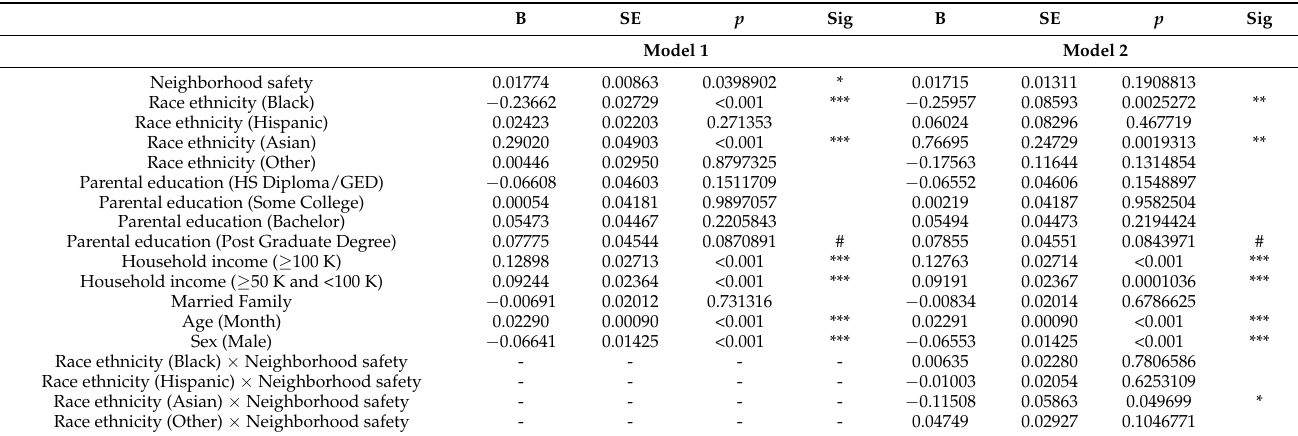
Table 4. Summary of mixed-effects regressions on the association between parent’s neighborhood safety and children’s cognitive performance (executive functioning) overall and by race/ethnicity.